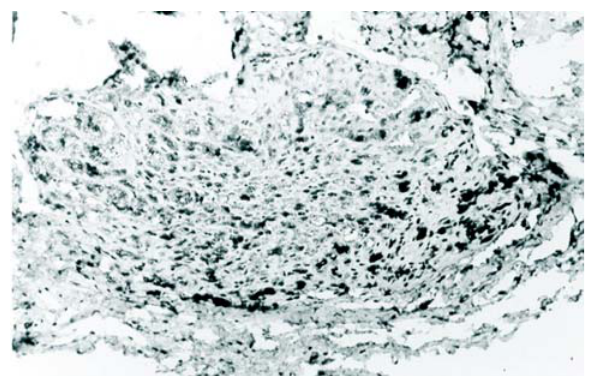
Figure 3 – Histologic section showing encapsulated adrenal cor- tical tissue with focal calcification (HE,